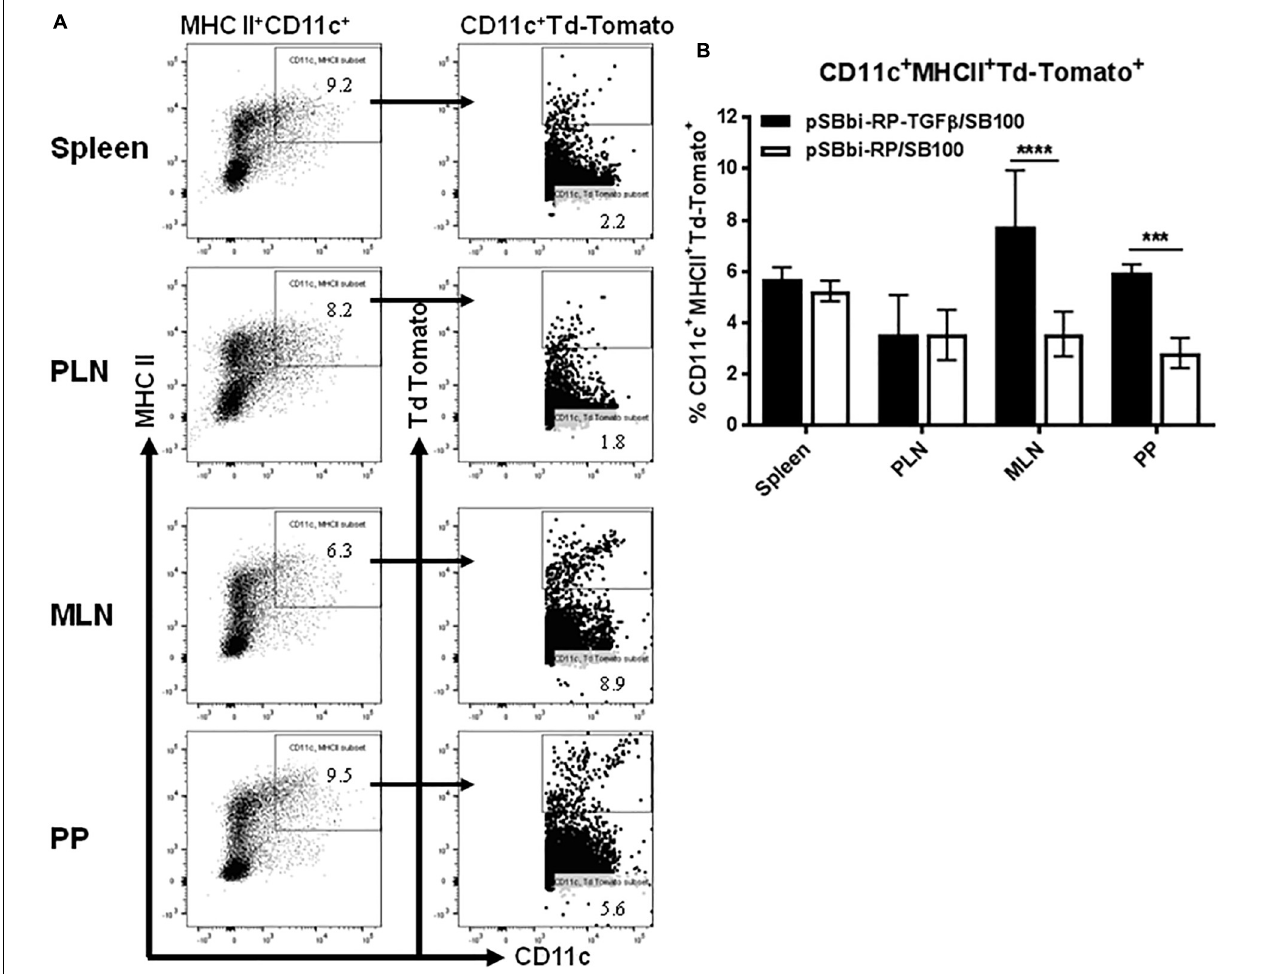
FIGURE 3 | Vaccine-delivered TGF β alters levels of DCs in secondary lymphoid tissues. NOD mice were given a single oral dose of Salmonella (pSBbi-RP-TGF β /SB100, n = 10) or Salmonella (pSBbi-RP/SB100, n = 10). Four weeks post-vaccination, red fluorescent protein was detected in DCs of different organs. (A) Representative FACS plots gated the frequency of MHCII + CD11c + Td-Tomato + cells in the spleens, PLN, MLN, and PP of mice from each group. (B) Quantification of the percentages of MHCII + CD11c + Td-Tomato + cells in the spleen, PLN, MLN, and PP. The data shown are the average with SD from